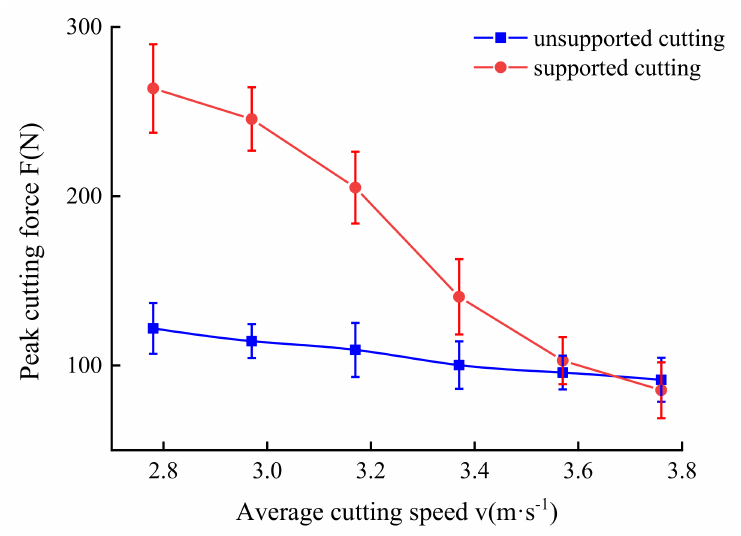
Figure 7. Relationship between average cutting speed and peak cutting force. Note: branch diameter is 9–10 mm; wedge angle is 25 ◦ ; slip cutting angle is 25 ◦ ; cutting gap is 1 mm; cutting height is 5 cm; moisture content is